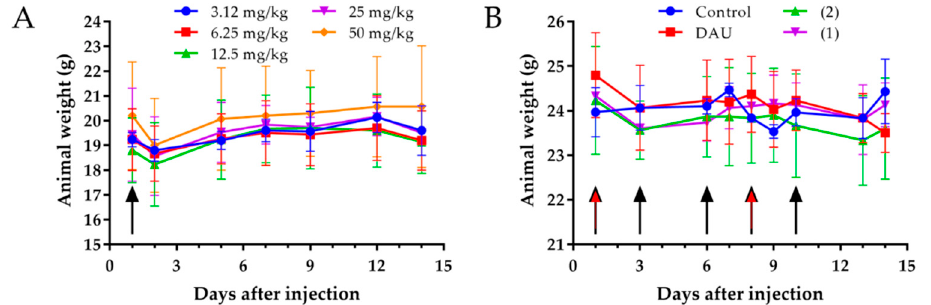
Figure 3. Animal body weight (grams, average ± SD). ( A ) Acute toxicity study of conjugate 2 with doses of 3.125, 6.25, 12.5, 25 and 50 mg / kg Dau content. ( B ) Chronic toxicity study of GnRH-III-Dau conjugates 1 and 2 with dose of 15 mg / kg Dau content, 5 treatments, black arrows; and free Dau 1 mg / kg, 2 treatments, red arrows. 3 mice per group.